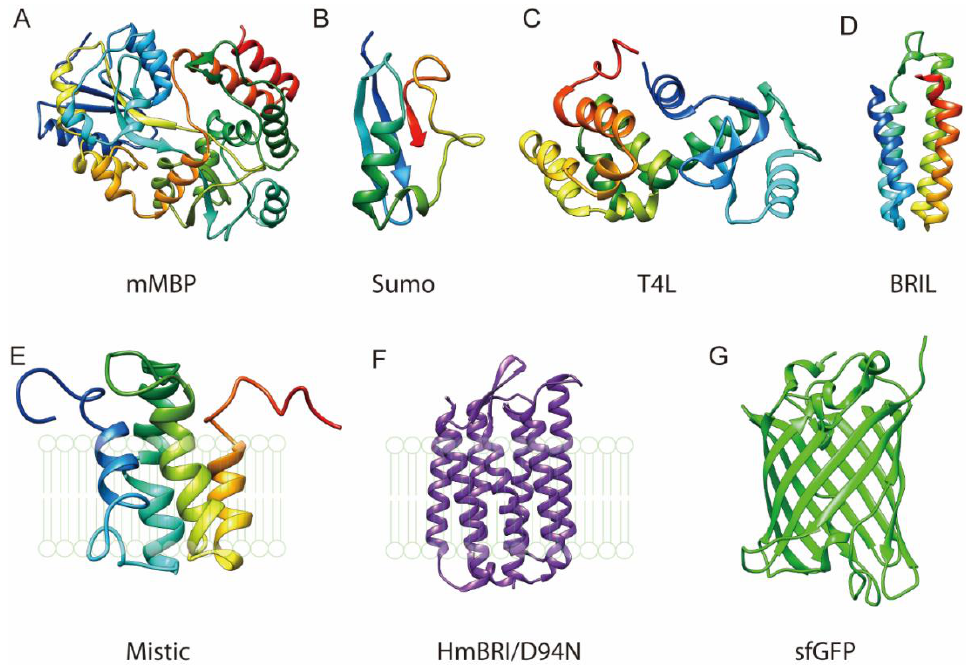
Figure 1. Various proteins that can be fused to membrane proteins to facilitate their expression and purification. ( A ) E. coli mature Maltose binding protein (MBP), PDB 1ANF. ( B ) S. cerevisiae Ubiquitin-like protein SMT3 (SUMO), PDB 3TIX, Chain A. ( C ) E. virus T4 Lysozyme (T4L), PDB 2LZM. ( D ) E. coli B562RIL (BRIL), PDB 1M6T. ( E ) B. subtilis Mistic, PDB 1YGM. ( F ) H. marismortui bacteriorhodopsin I D94N mutant (HmBRI/D94N). ( G ) A. victoria Superfolder GFP (sfGFP), PDB 2B3P. MBP, SUMO, T4L and BRIL are soluble proteins. MBP and SUMO are usually fused to the N terminus of the target membrane protein. T4L and BRIL are usually inserted in a membrane protein between its two TMs (e.g., TM5 and TM6 of a GPCR). Mistic and HmBRI/D94N are membrane proteins. HmBRI/D94N has a purple color and sfGFP has green fluorescence.